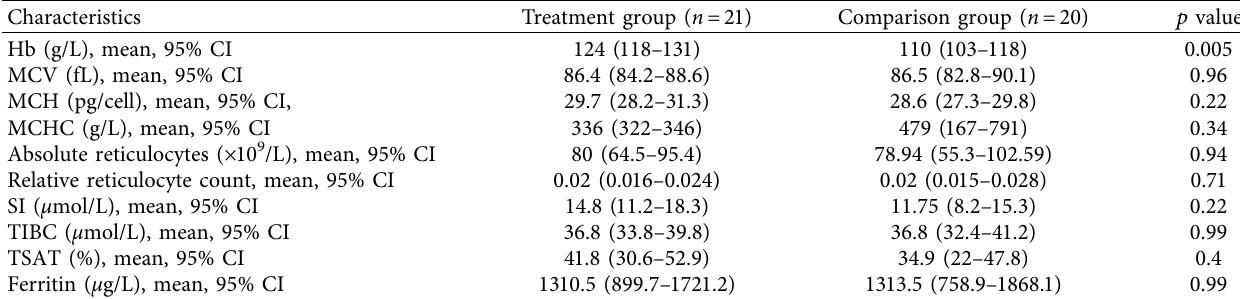
Table 2: Comparative characteristics of the treatment group versus the comparison group at the end of the study period.